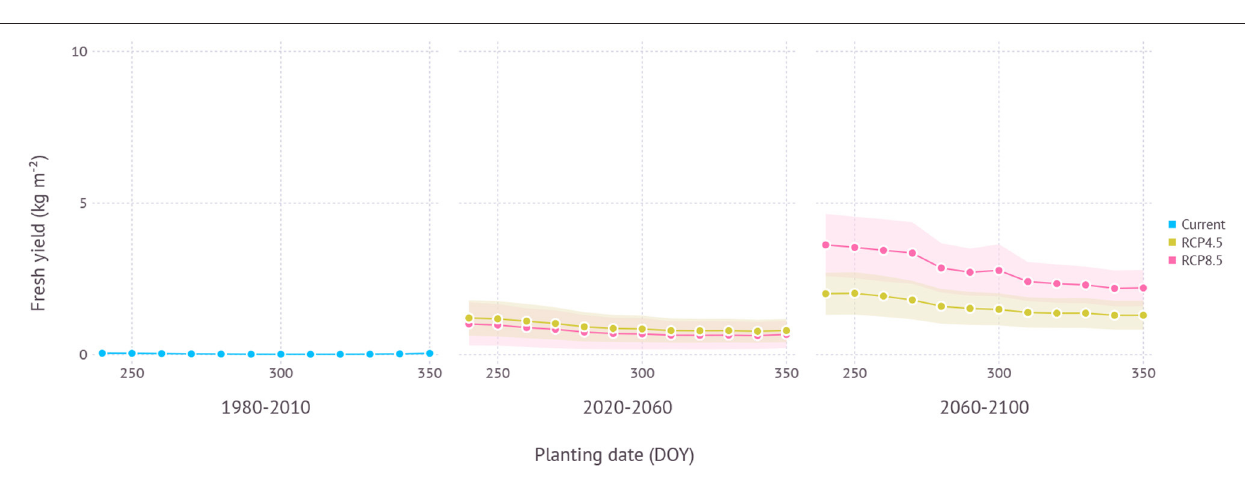
FIGURE 10 | Yield estimation within a range of planting dates under current and future climate projection in Chuncheon, Gangwon where the current climate is not favorable for growing ND cultivar. The current climate indicates simulation results with 30-years of normal weather data from 1980–2010. Shades represent a range of ± 1 SD from mean fresh